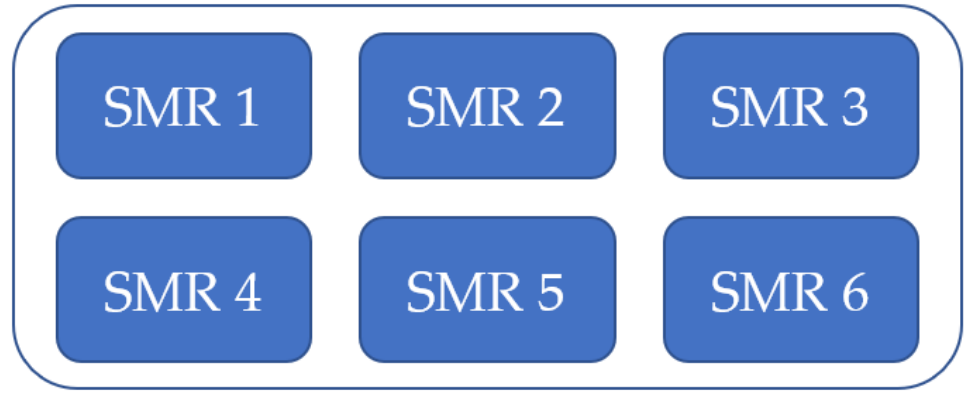
Figure 4. Modularization of an SMR power station/s.